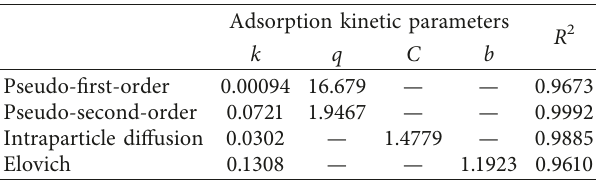
Figure 4: Effect of the adsorbent dose by modified rice stem. Table 2: Adsorption kinetic parameters of uranium(VI) adsorption by modified rice